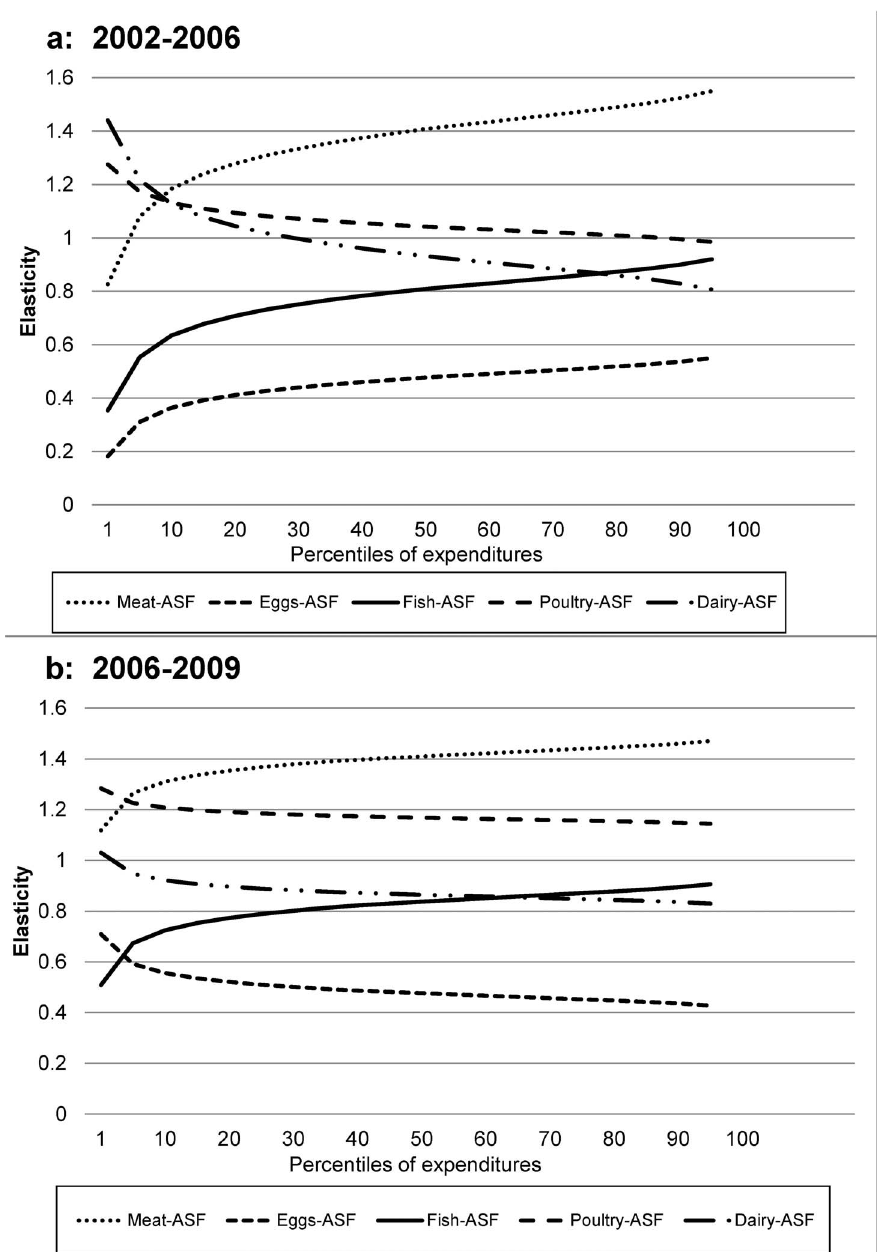
Figure 4. Elasticities of ASF components with reference to total ASF expenditures. Elasticities for individual ASF component expenditures are constrained to be consistent with elasticity for total ASF expenditures. ( a ) From 2002–2006 elasticities are not significantly different from 1 for meat below the 10 th percentile, for poultry above the 15 th percentile, for dairy between the 15 th and 75 th percentiles, and for fish . 70 th percentile. Elasticities with respect to total ASF expenditures are always significantly different from 1 for eggs. ( b ) From 2006–2009 elasticities are not significantly different from 1 for fish between the 10 th and 25 th percentiles. Elasticities with respect to total ASF expenditures are always significantly different from 1 for meat, poultry, dairy and eggs.